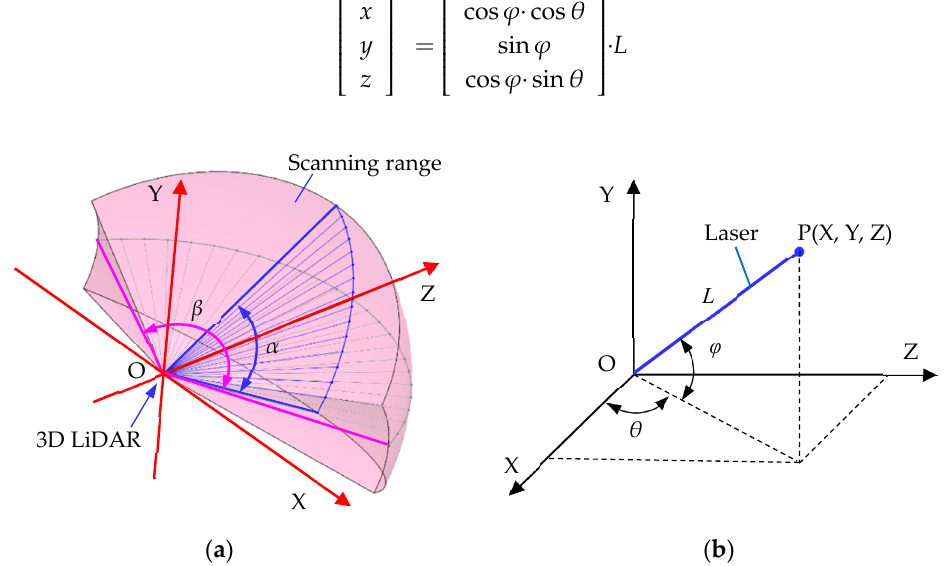
Figure 6. Schematic diagram of 3D LiDAR detection: ( a ) the scanning range of the 3D LiDAR; ( b ) schematic diagram of the radar detection results transformation.